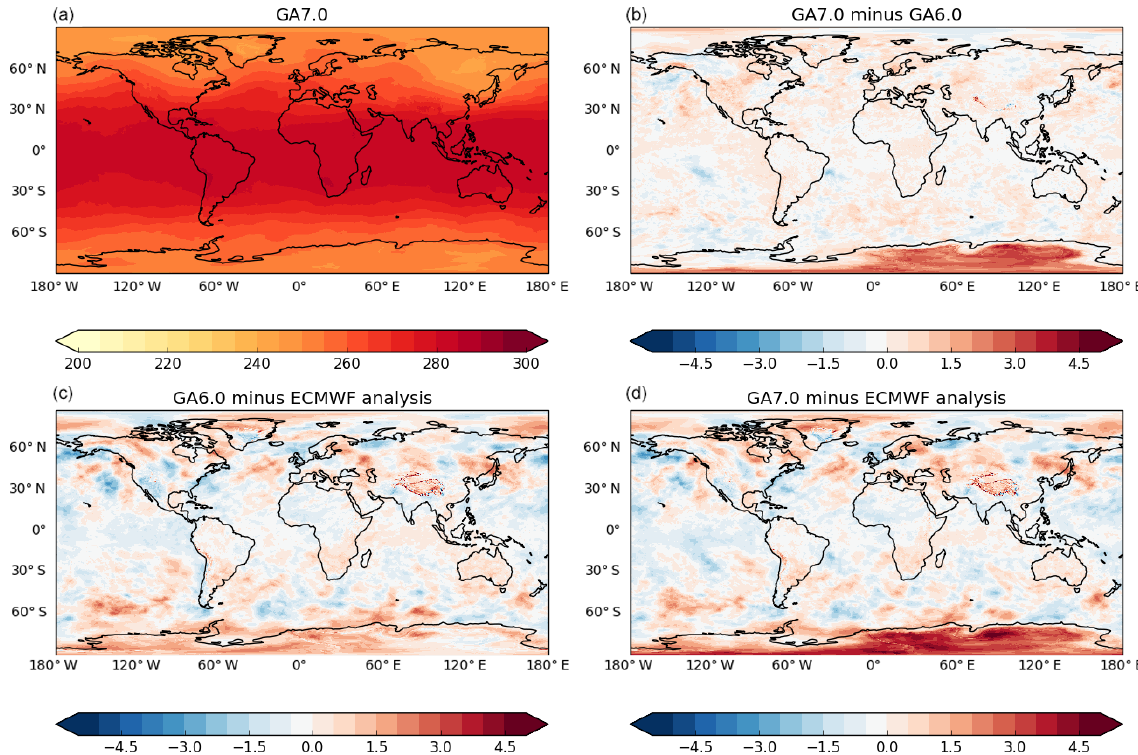
Figure 24. T + 120 temperature (K) at 700hPa meaned over the 12 pairs of forecasts included in Fig. 21 that were initialised in DJF. The panels show the mean GA7.0 forecast (a) , the difference between GA7.0 and GA6.0 forecasts (b) , and the bias compared to the verifying ECMWF analyses in GA6.0 (c) and GA7.0 (d)